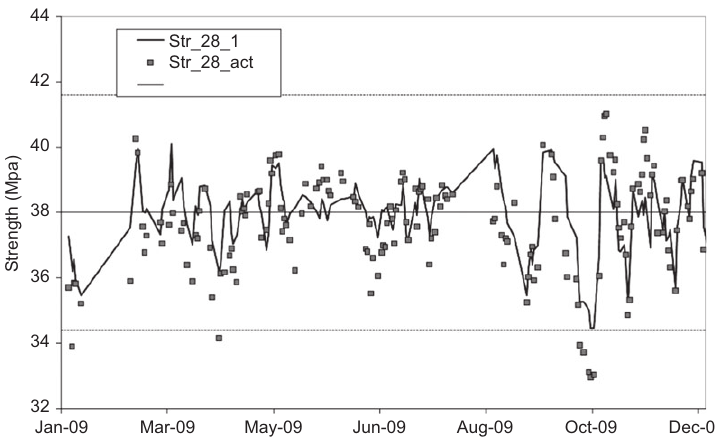
Figure 11 SM application for CEM BM 32.5